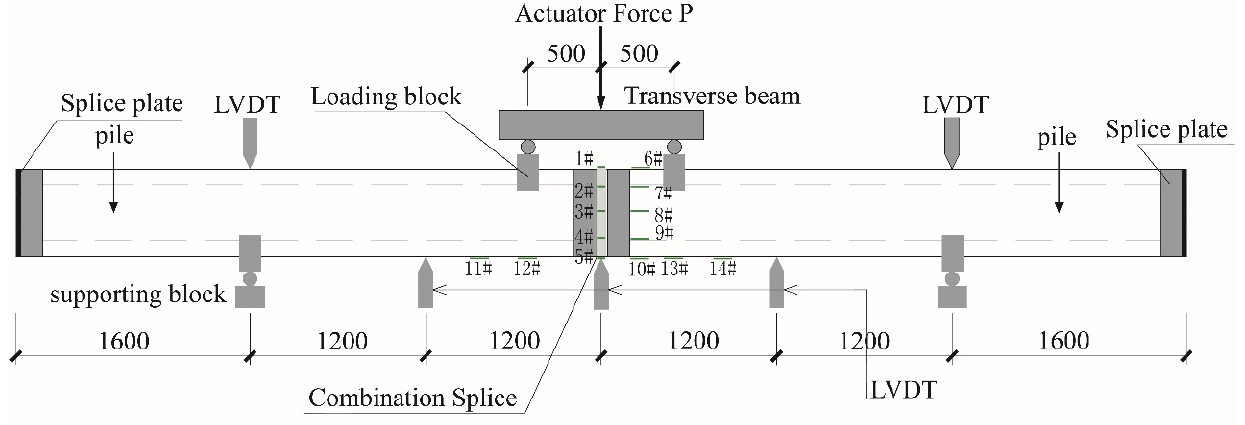
Figure 6. Schematic diagram of the bending test setup and instruments.